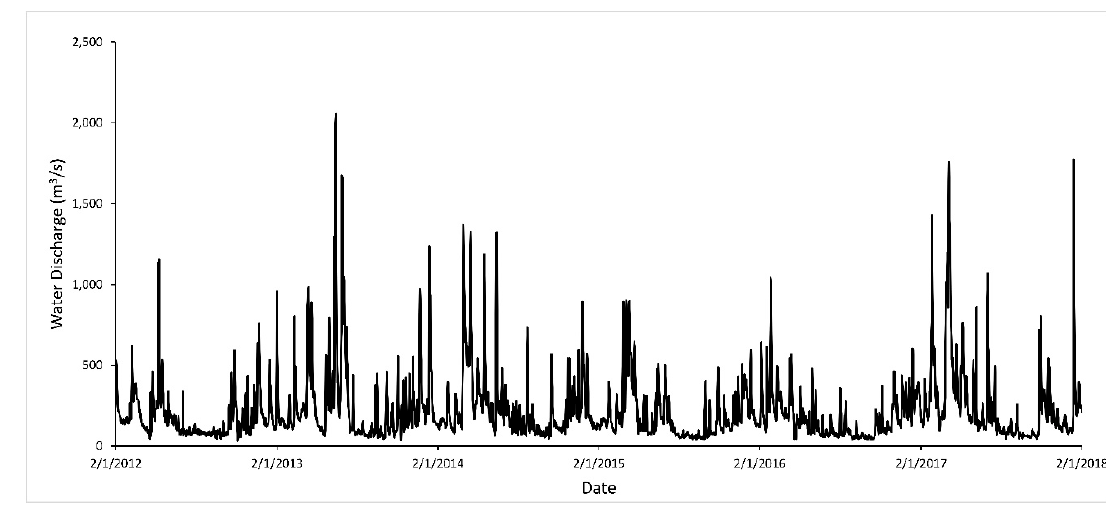
Figure 2. A line plot depicting the raw water discharge data (prior to logarithmic transformation) in cubic meters per second (N = 2191) for six years (2/1/2012 to 2/1/2018). Peaks indicate high rates of water discharge, and valleys represent low rates of water discharge.